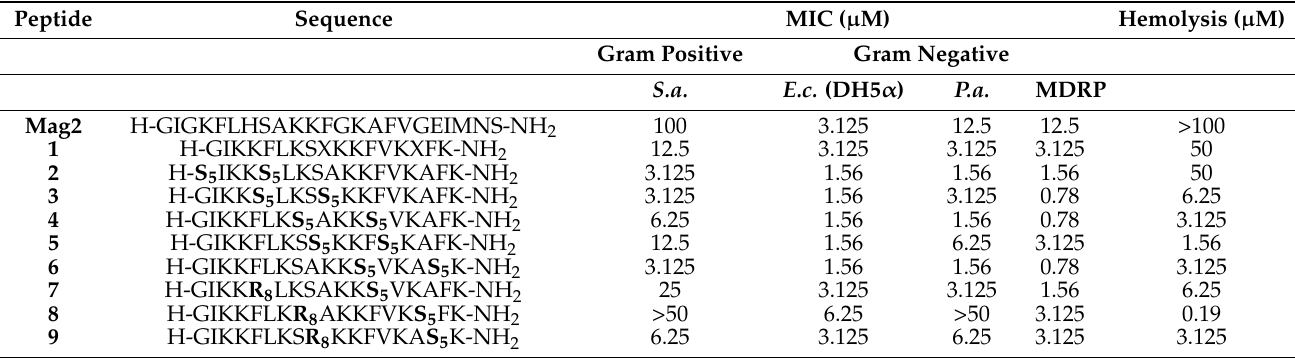
Table 1. Peptide sequences of Mag2 and tested peptides 1 – 9 , antimicrobial activity against gram-positive and gram-negative bacteria, and hemolytic activity against red blood cells (RBCs). X indicates the replacement of amino acid residue with Aib